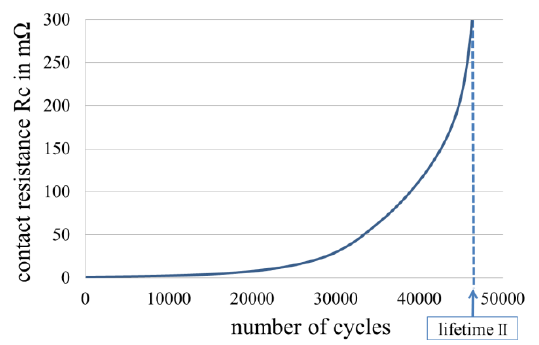
Figure 1. Lifetime in fretting corrosion